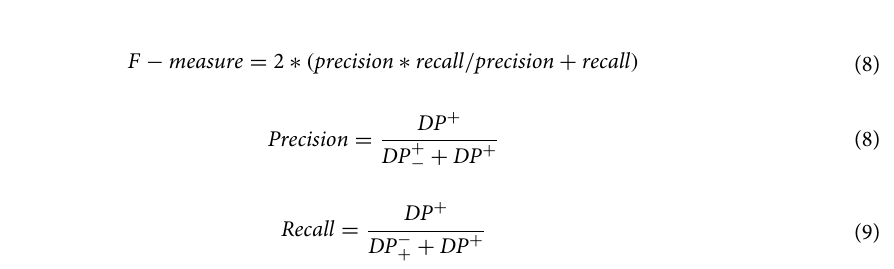
Table 2. Performance of classifiers before feature